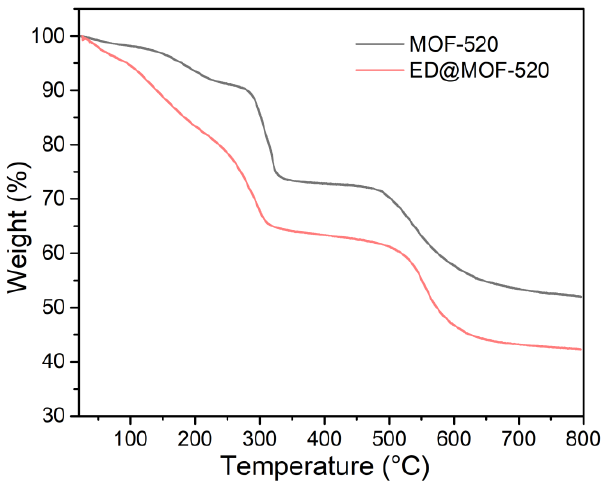
Figure 3. TGA curves of